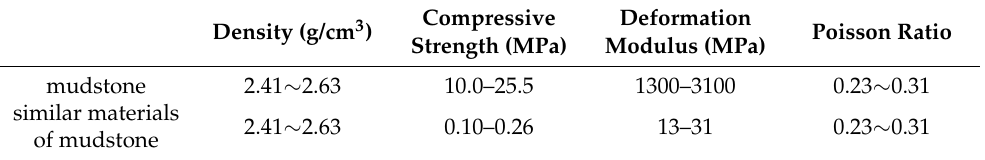
Table 1. Physical and mechanical indexes of mudstone and similar